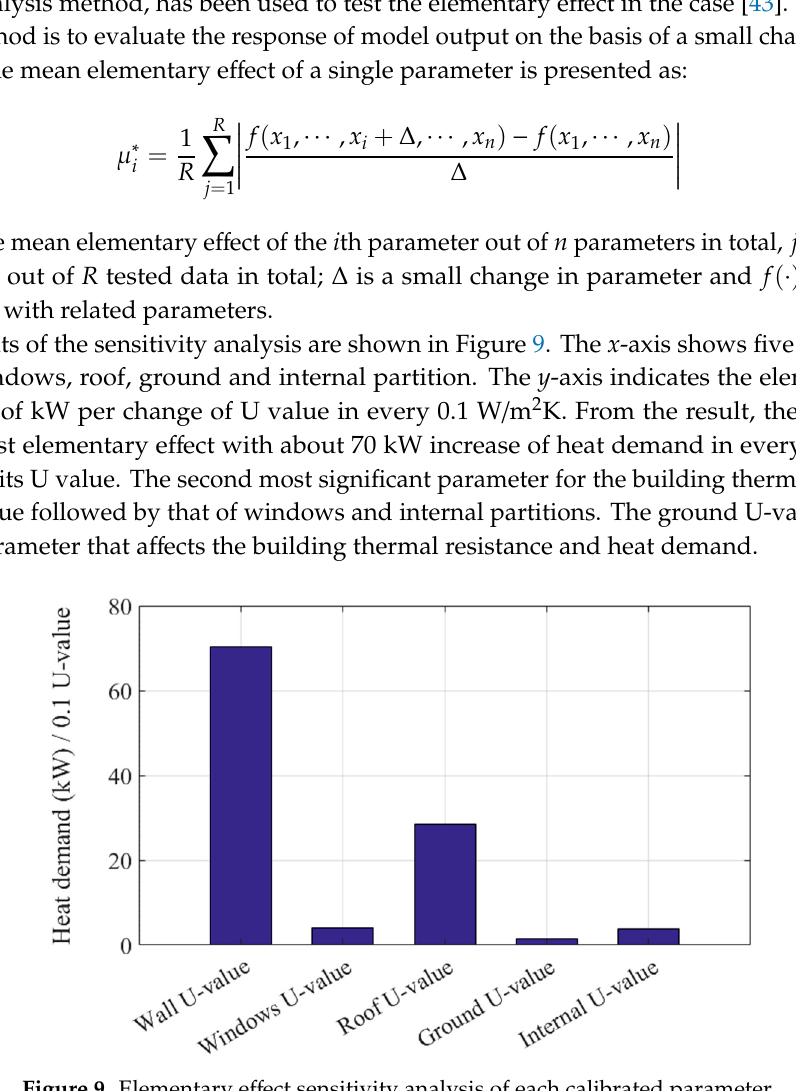
Figure 10. Prediction result using IES-VE comparing with recorded monthly heat demand.